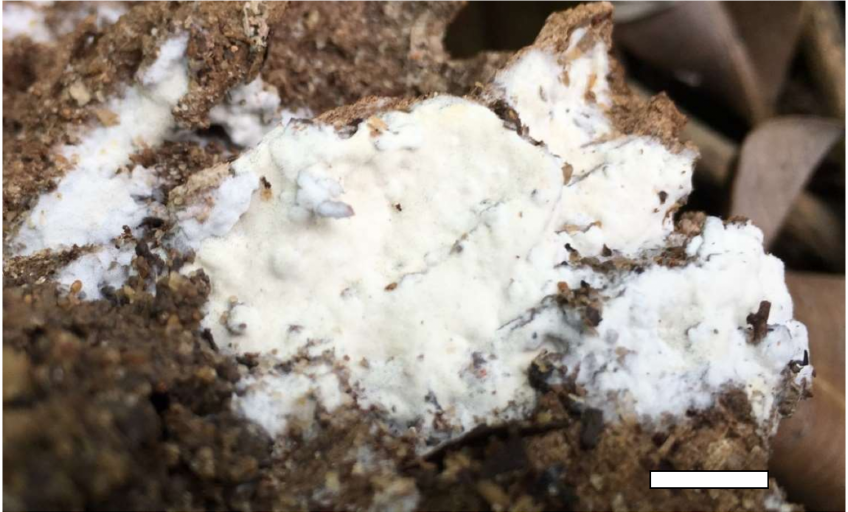
Figure 6. A basidioma of Sidera malaysiana (from the holotype Dai 18570). Scale bar = 10